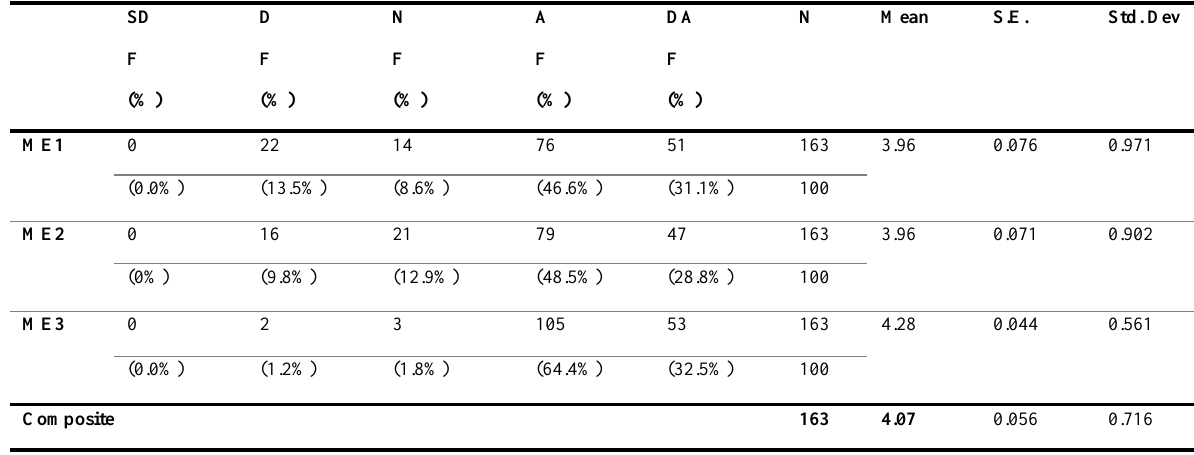
Table 1: Participation in Monitoring and evaluation and sustainability of donor funded livelihood projects in Kilifi